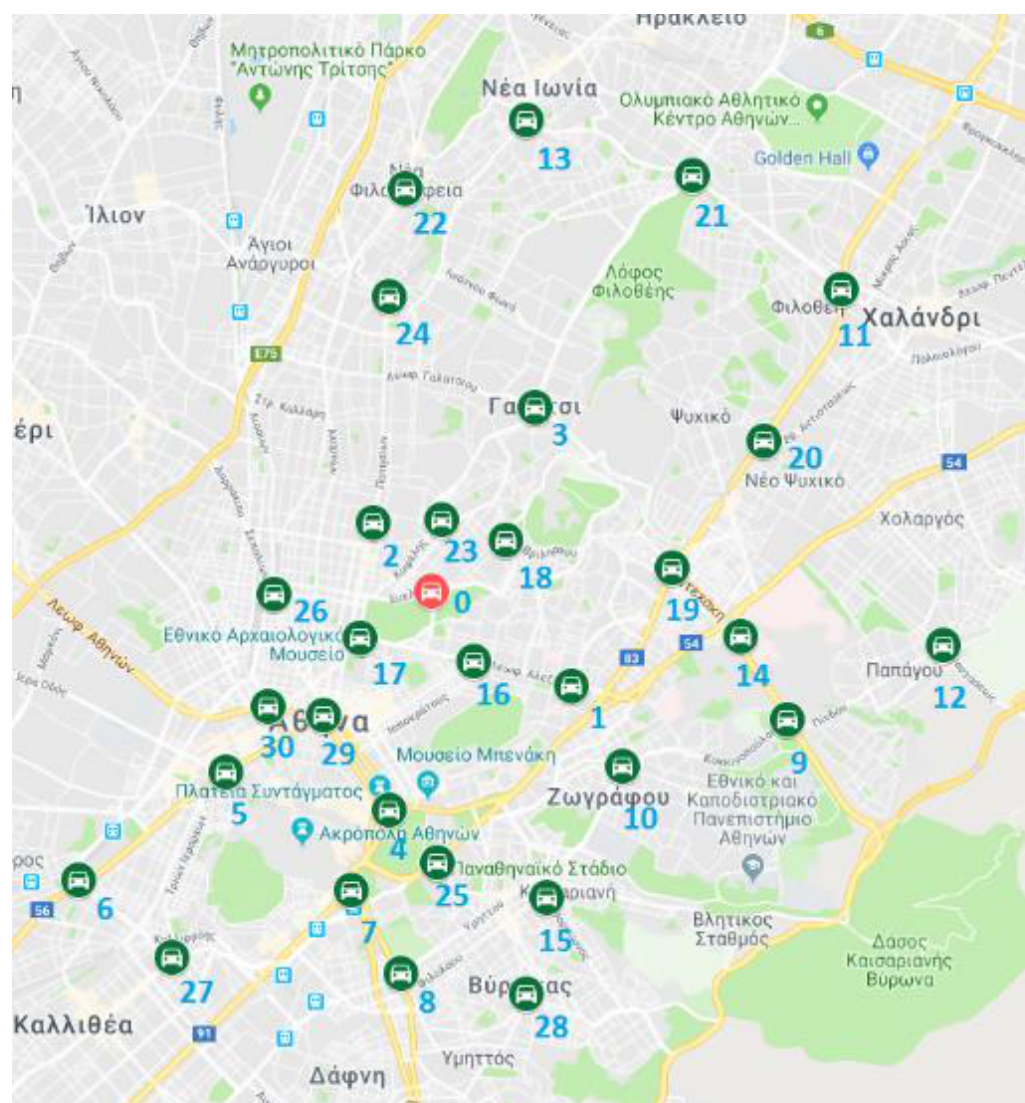
Figure 1. Area of application (source: Google Maps) .